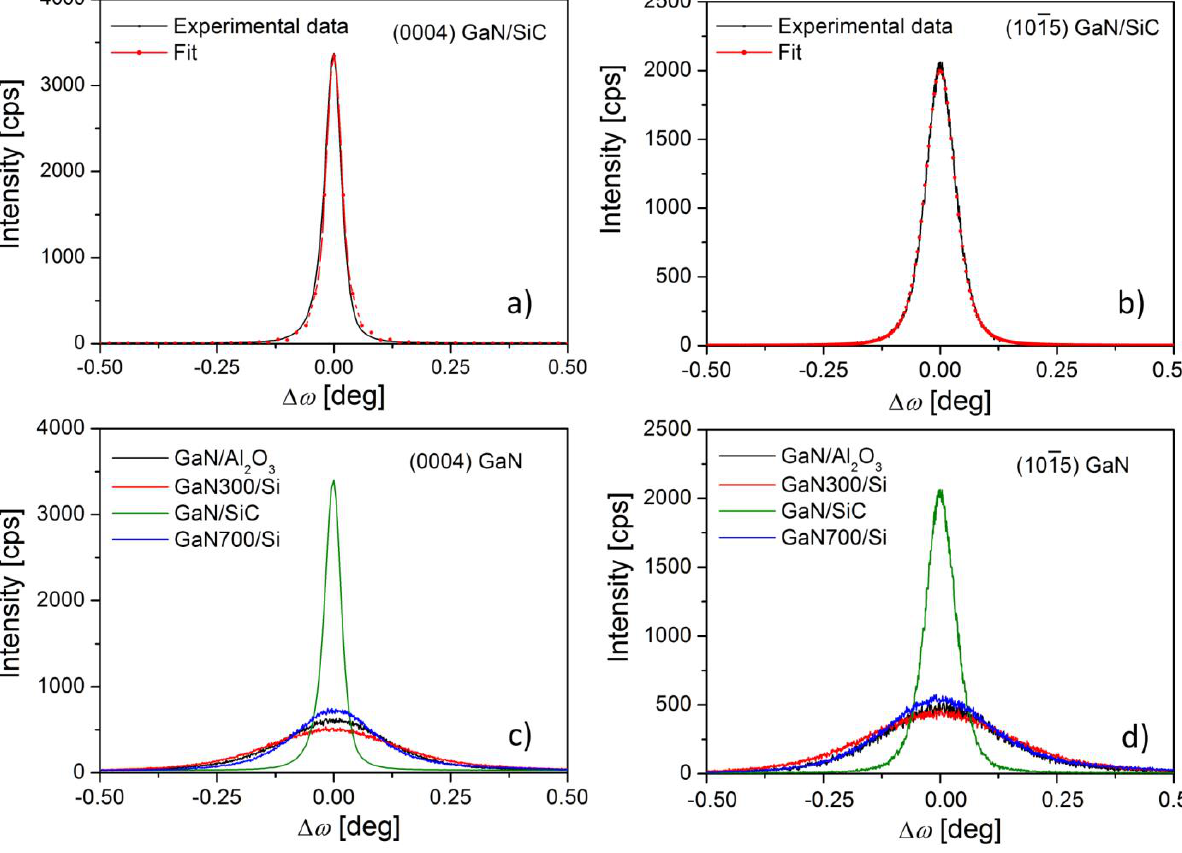
Figure 4. Omega scans (experimental and fits) around (0004) plane ( a ) and ( 1015 ) plane ( b ) of GaN films grown on (111) 3C-SiC substrate. For comparison we present in ( c , d ) the omega scans around (0004) and ( 1015 ) planes, respectively, for GaN films grown on (0001) Al 2 O 3 and (111) Si substrates